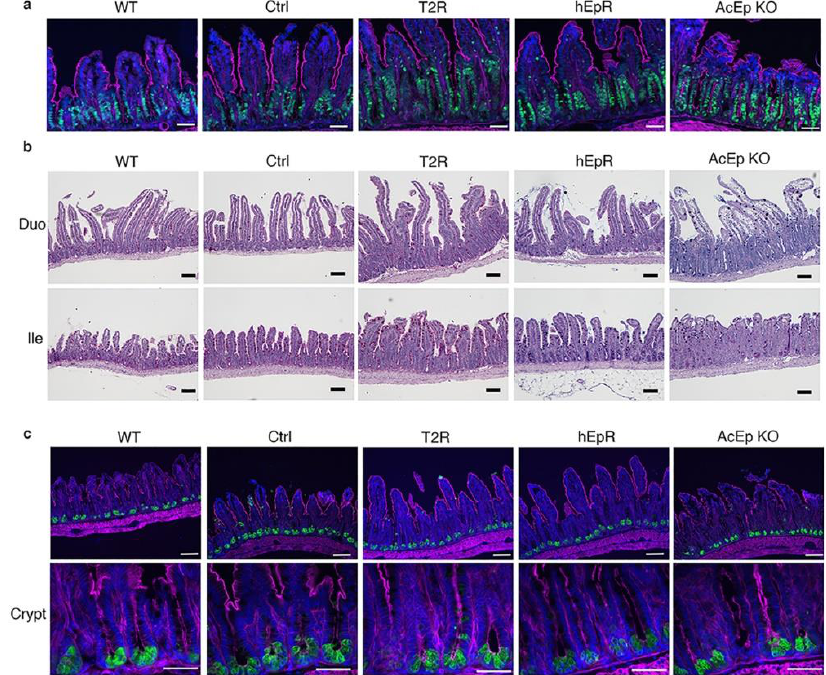
Figure 4. Characterization of IEC in TROP2 rescue mice and relevant controls. ( a ) Detection of proliferating cells in intestinal crypts by immunostaining. Ki-67 (green), F-actin (magenta), nuclei / DAPI (blue). Scale bars, 50 μm . ( b ) Goblet cells are visualized in fixed tissue sections using Alcian-PAS staining and light microscopy. Scale bar, 100 μm . ( c ) Identification of lysozyme-expressing Paneth cells in ileal tissue by immunostaining. Lysozyme (green), F-actin (magenta), and nuclei / DAPI (blue). Upper panel scale bars, 50 μm . Lower panel scale bars, 50 μm.